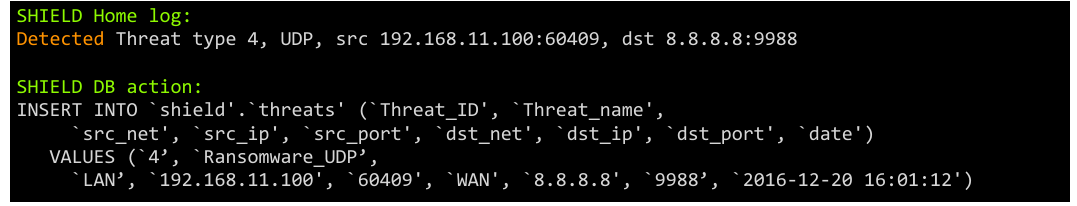
Figure 6. Detection of Ransomware attack on UDP.